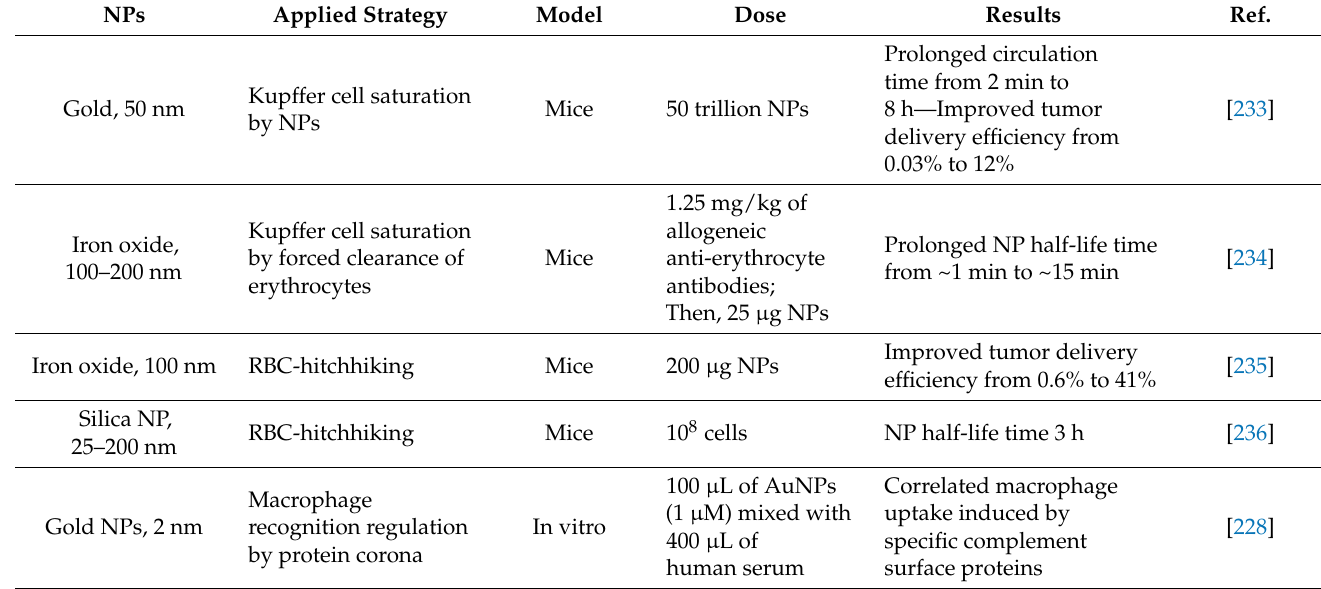
Table 2. Strategies used to prolong the circulation of NPs in the bloodstream.